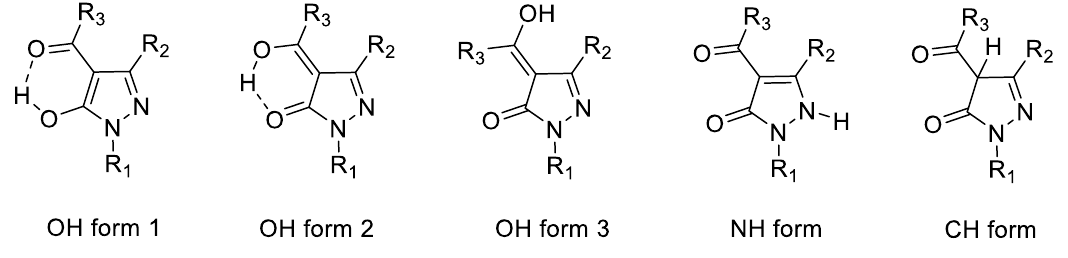
Figure 4. Di ff erent tautomeric forms of